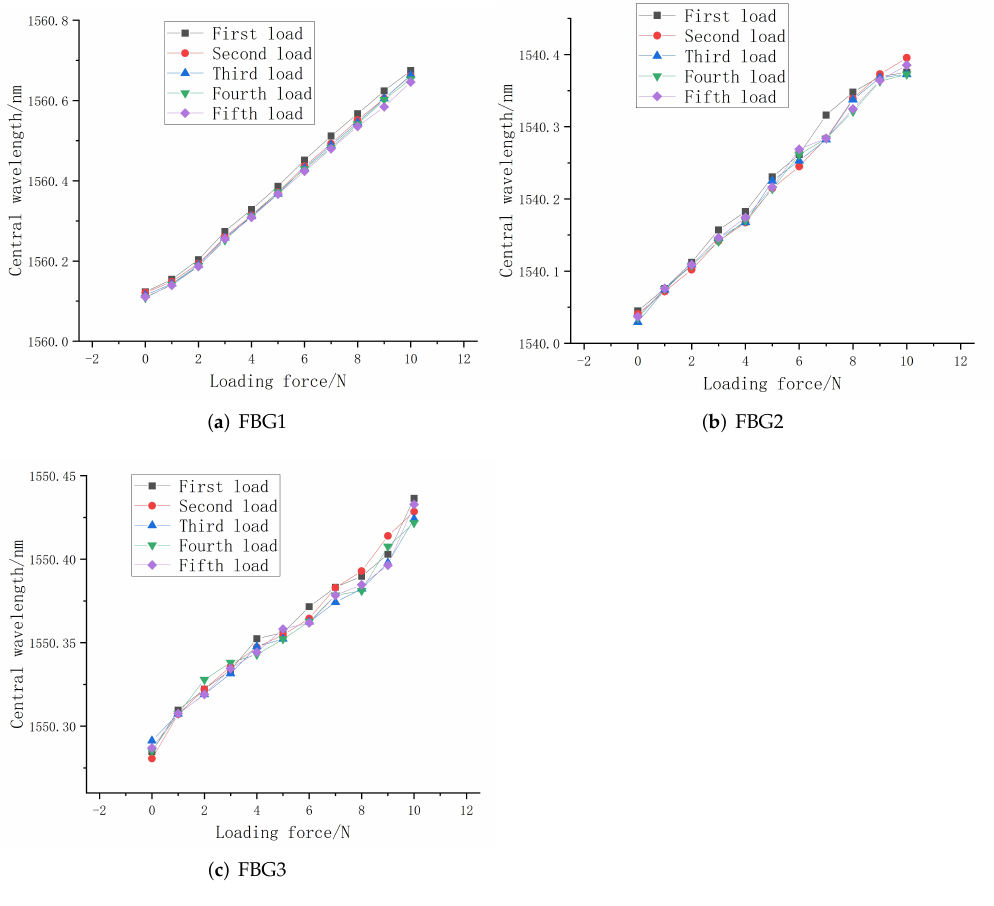
Figure 21. Repeatability fitting